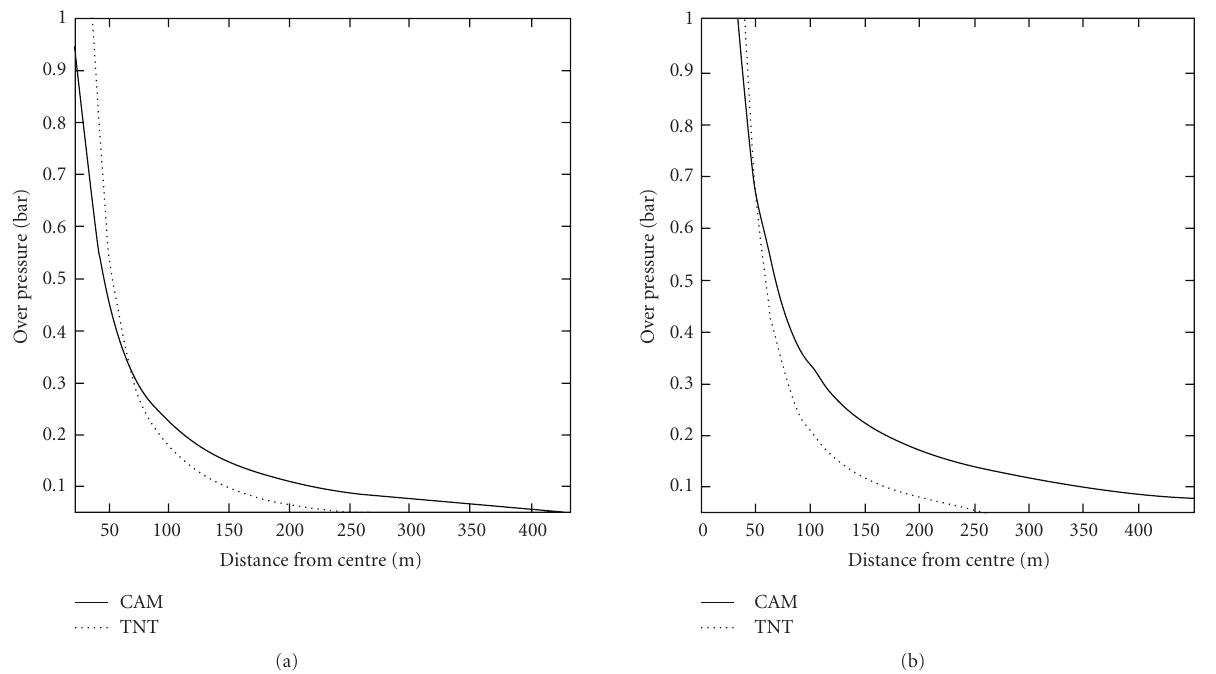
Figure 5: Overpressure to distance curves for TNT and CAM method for propane (a) and propene (b).